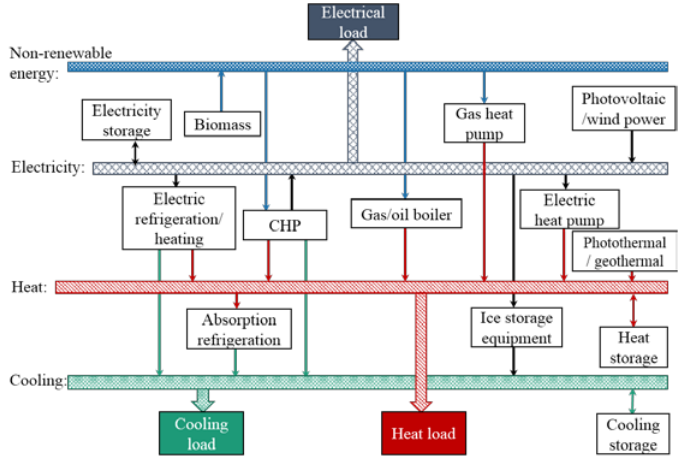
Figure 1. Schematic diagram of the integrated energy system.